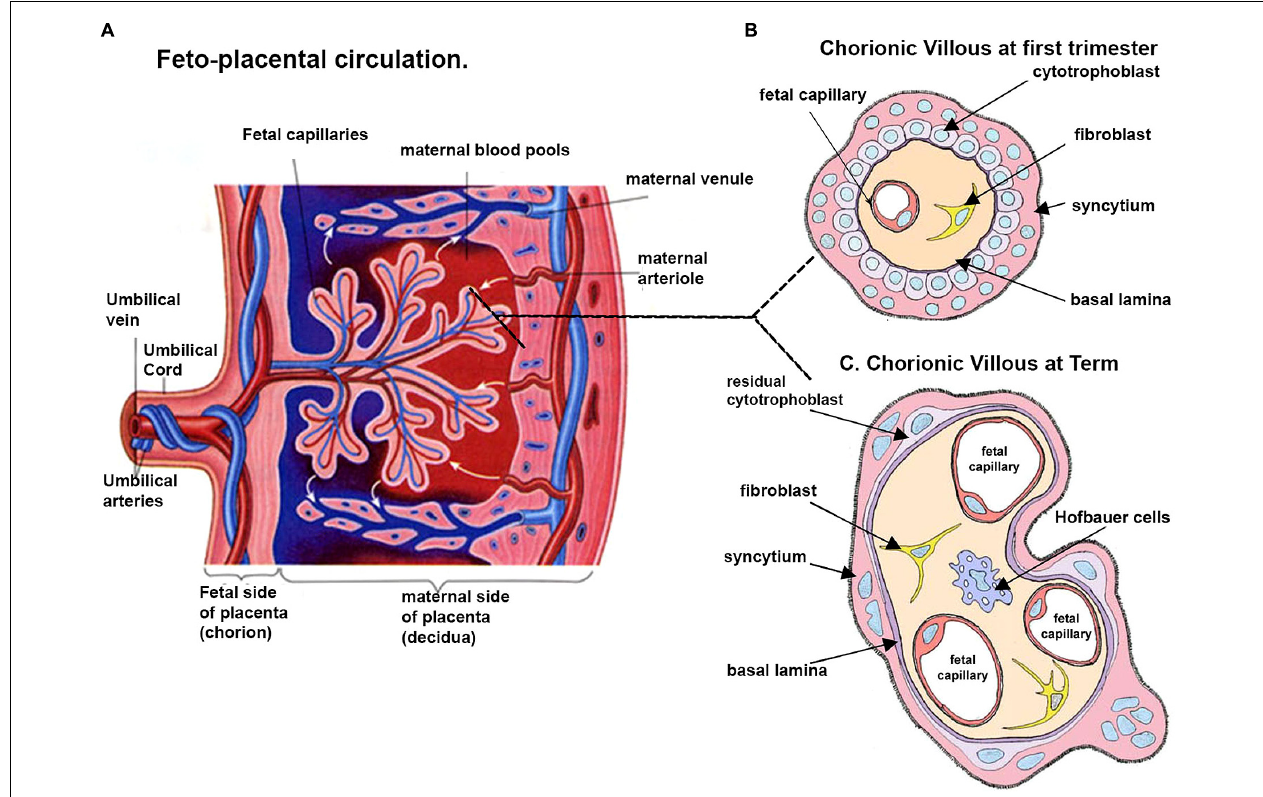
fibroblasts and the fetal capillaries. (C) At term, in some areas the placental membrane is so thin such that the syncytiotrophoblast comes into direct contact with the fetal capillary endothelium, and is thus called the vasculo-syncytial membrane. Adapted and modified from http://imueos.wordpress.com/2010/05/25/placenta-function/ and from